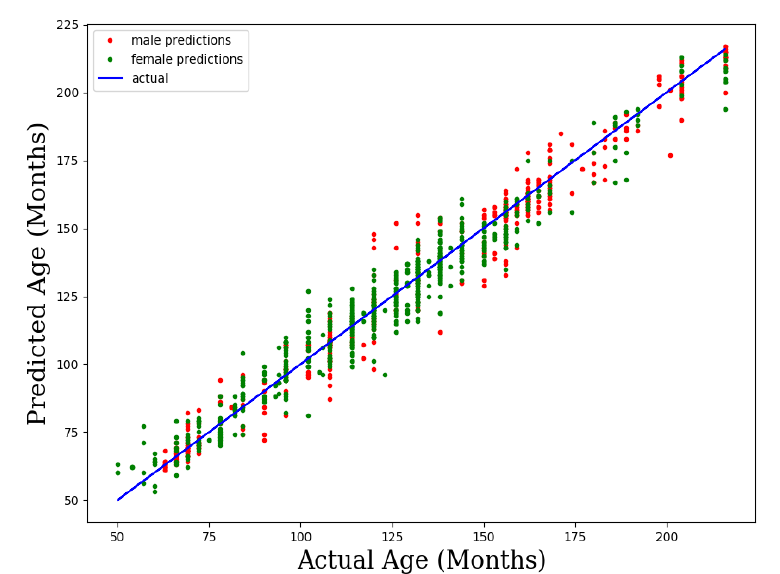
Figure 8. Identity lines for males and females.